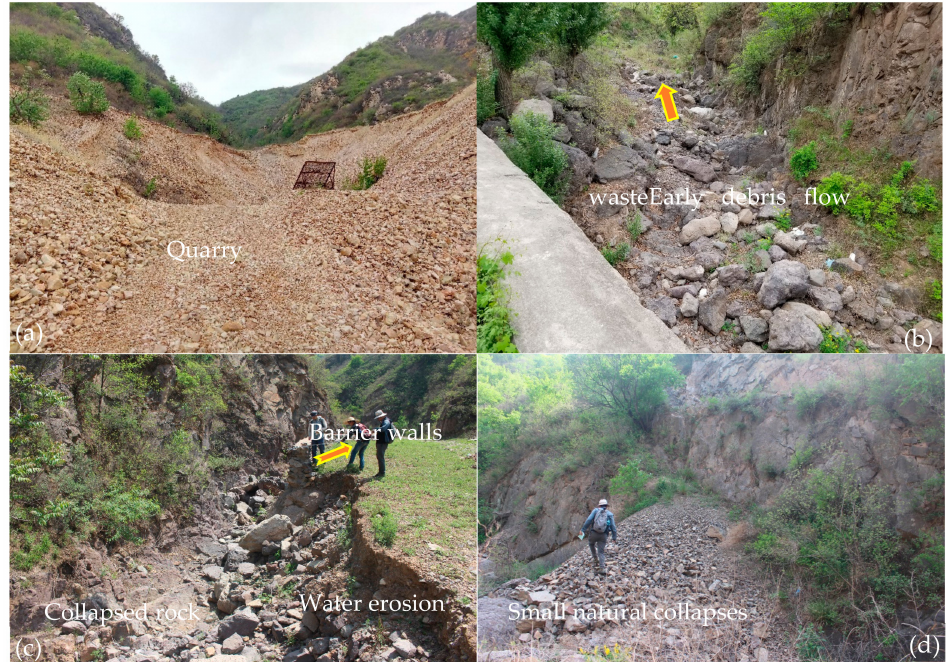
Figure 3. Field investigation in the study area. ( a ) Waste broken slag; ( b ) loose material source in the channel; ( c ) water erosion in the channel; ( d ) small collapse on both sides of the channel.